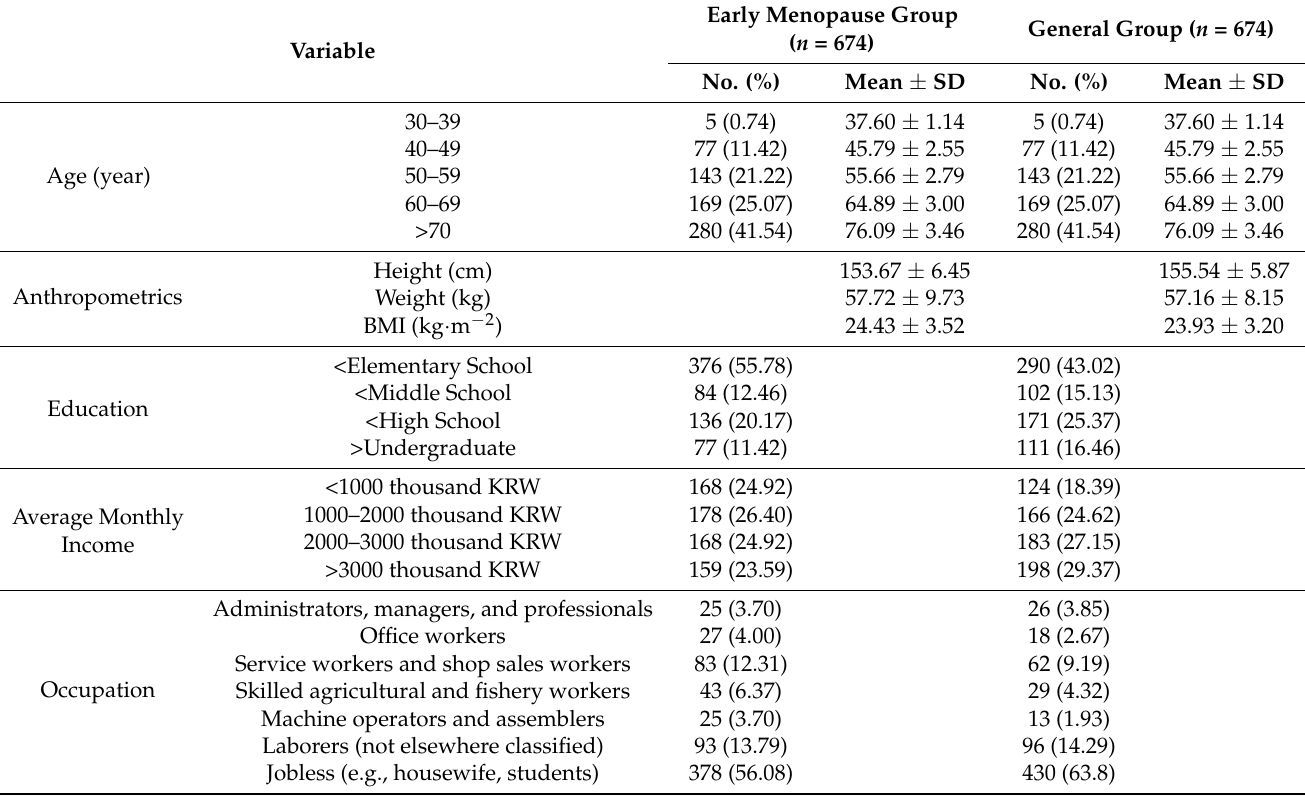
Table 1. Participants’ characteristics information between the early menopausal group and the general group.